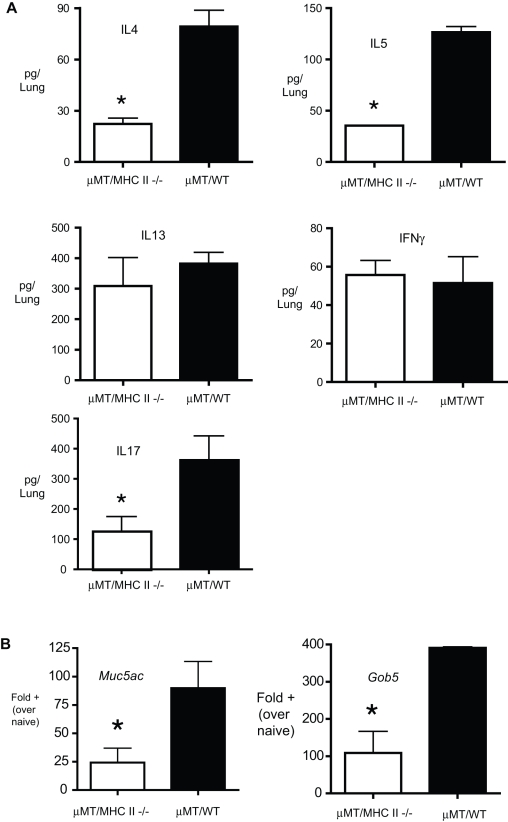
Role of B cell expression of MHC II in allergic disease.(A) Lung cytokines and (B) mucus-associated gene expression in the lungs of µMT/I-Ab−/− mice and µMT/WT mice. Mice with MHC II deficient (µMT/I-Ab−/− mice) or normal (µMT/WT ) B cells were generated using mixed bone marrow chimeras, and chronically challenged with allergen. The levels of cytokines in the lungs were determined from lung homogenate samples via Bioplex multiplex assay. The expression of mucus associated genes was assessed by real-time PCR using whole lung RNA. Bars represent the mean ±SEM of 4 mice per group. * = p<0.05 Similar results were obtained in two independent experiments.